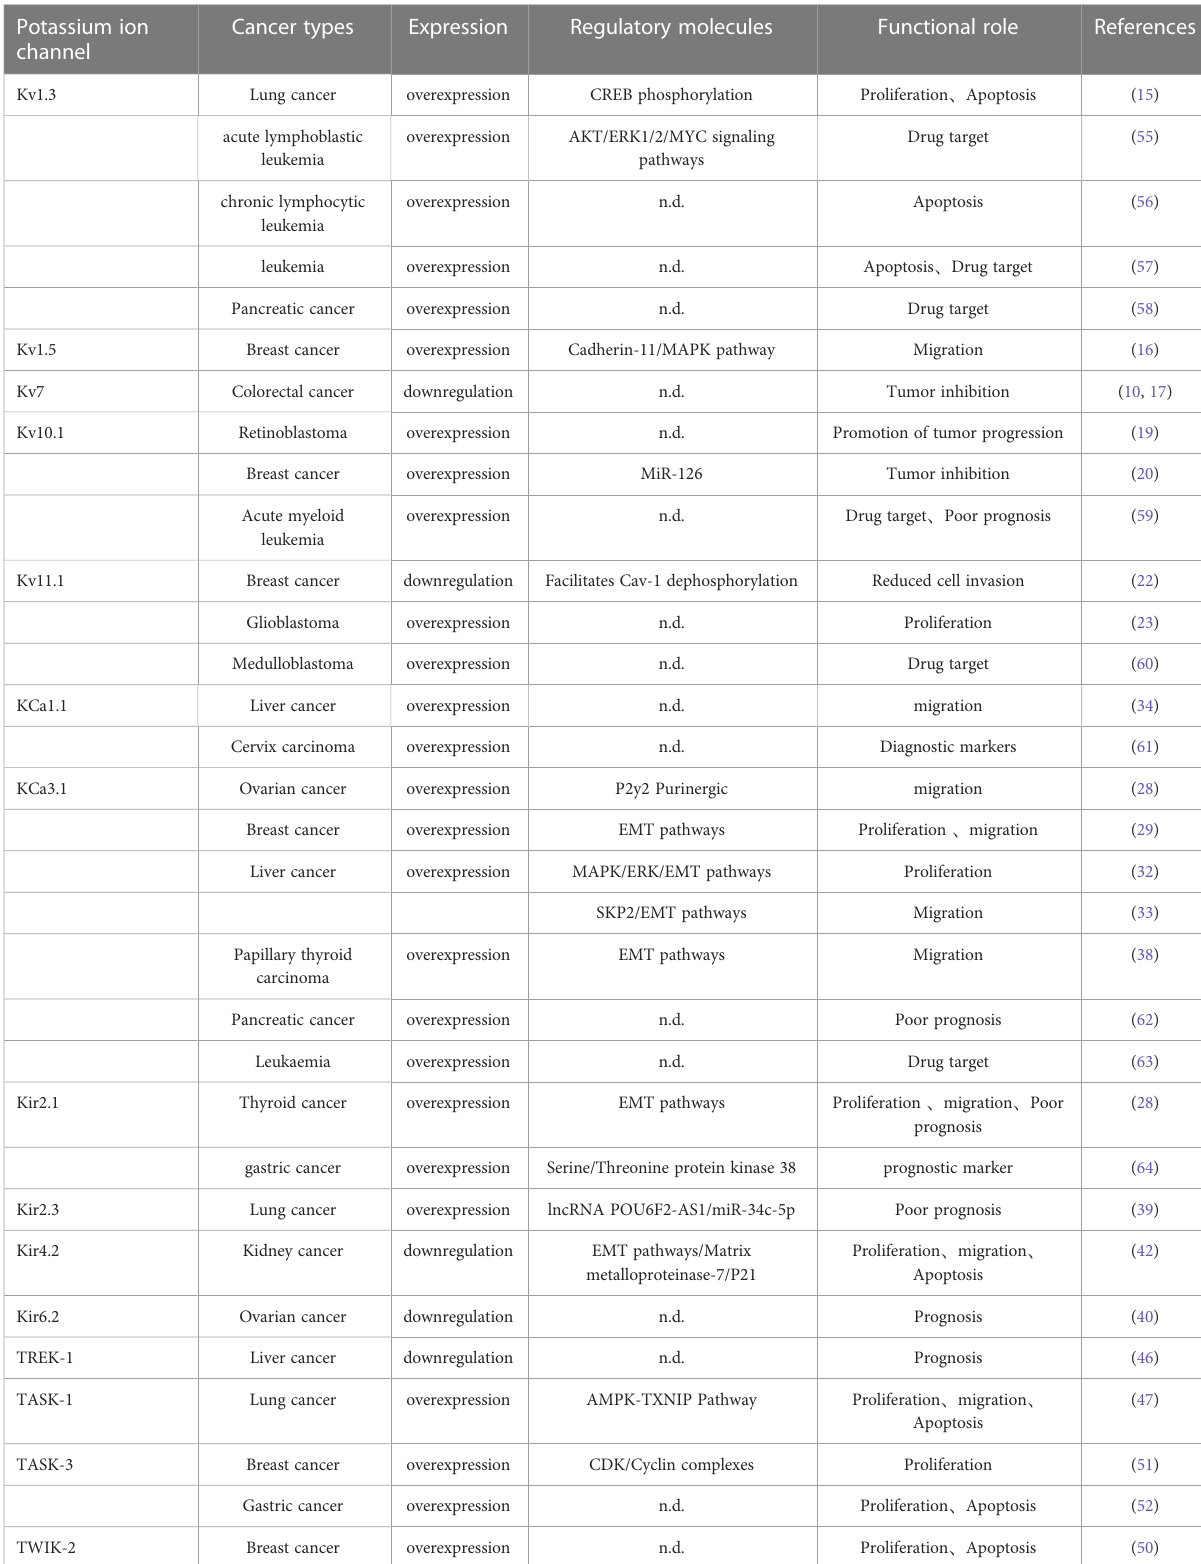
TABLE 1 Mechanism of potassium channel involved in tumor